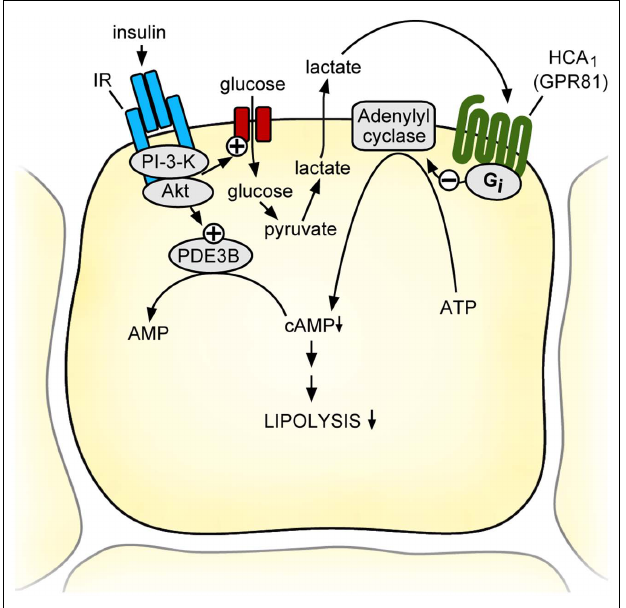
FIGURE 2 | Model of the physiological function of the HCA 1 receptor. During feeding, adipocytes can produce and release significant amounts of lactate, a process stimulated by insulin-induced glucose uptake. Lactate activates HCA 1 receptors on adipocytes in an autocrine and paracrine fashion and decreases intracellular cAMP levels through G i /G o -dependent inhibition of adenylyl cyclase.This leads together with the insulin-dependent activation of PDE3B to increased degradation and decreased formation of intracellular cAMP resulting in an inhibition of lipolysis.Thus, the lactate receptor HCA 1 mediates the anti-lipolytic of insulin effects during the transition from the fed to the fasted state and thereby helps to preserve endogenous energy stores when food-derived nutrients are abundant. AC, adenylyl cyclase; IR, insulin receptor; PDE3B, phosphodiesterase 3B; PI3K, phosphatidylinositol-3-kinase; PKA, protein kinase A.